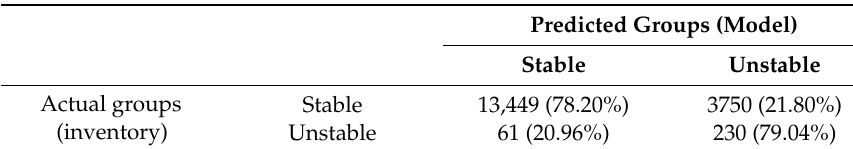
Table 6. Sample evaluation contingency table of G-GWR model.